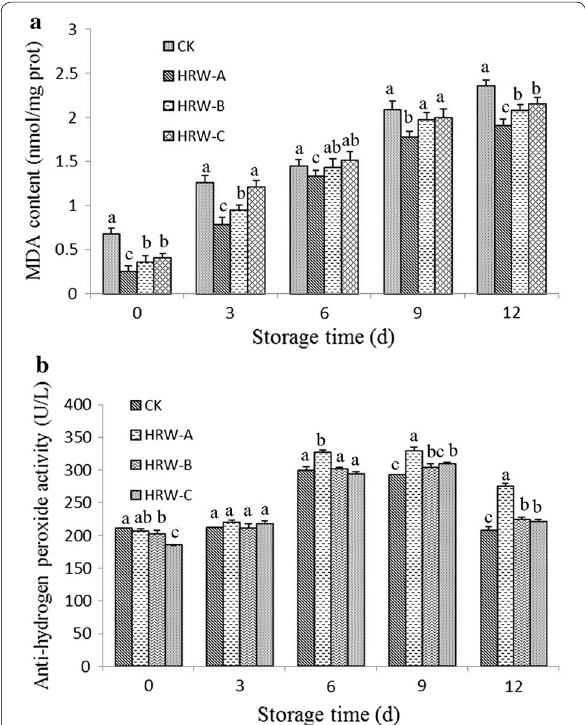
Fig. 4 Effects of HRW on the MDA content ( a ) and the inhibition of anti-hydrogen-radical activity ( b ) in fruit bodies of Hypsizygus marmoreus during storage at 4 °C. MDA malonaldehyde, Con control group. The data are presented as the mean SD of three independ- ± ent experiments. Bars with different letters denote a statistically sig- nificant difference compared with the control according to multiple comparisons (P <